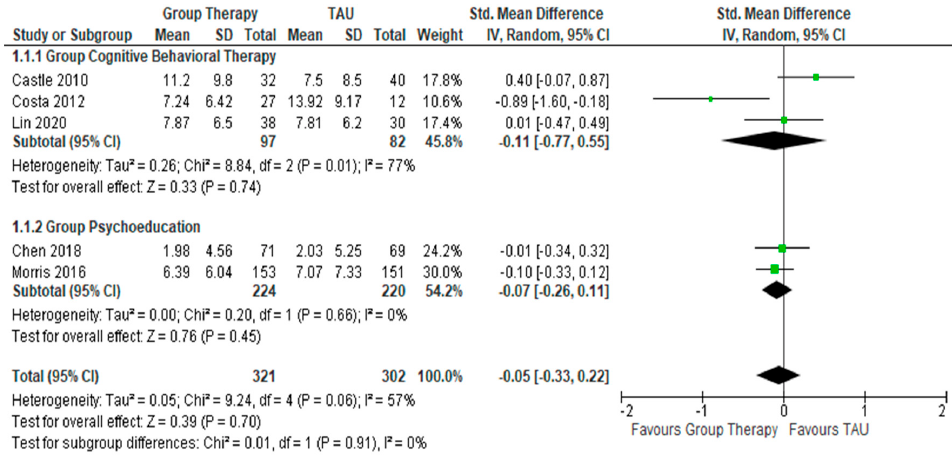
Figure 3. Forest plots for the changes in severity of depressive symptoms after interventions.